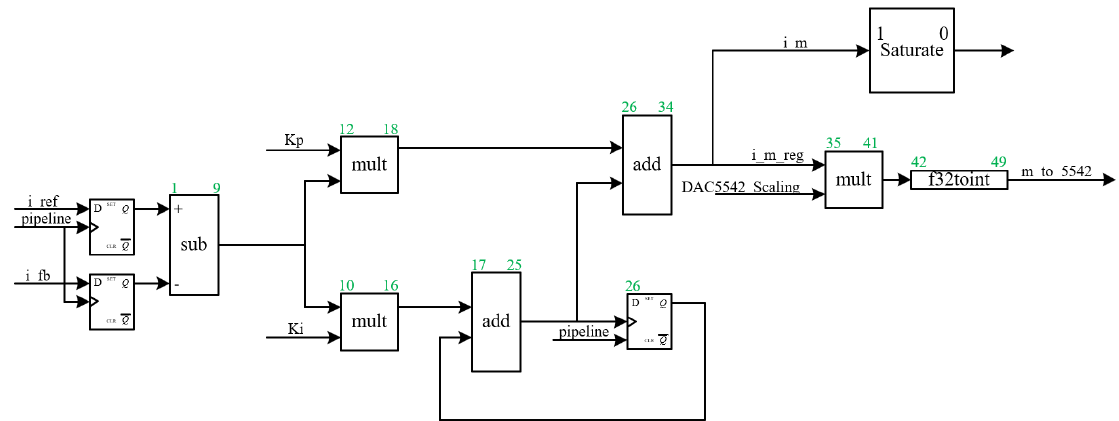
Figure 16. FPGA implementation diagram of PID control algorithm.